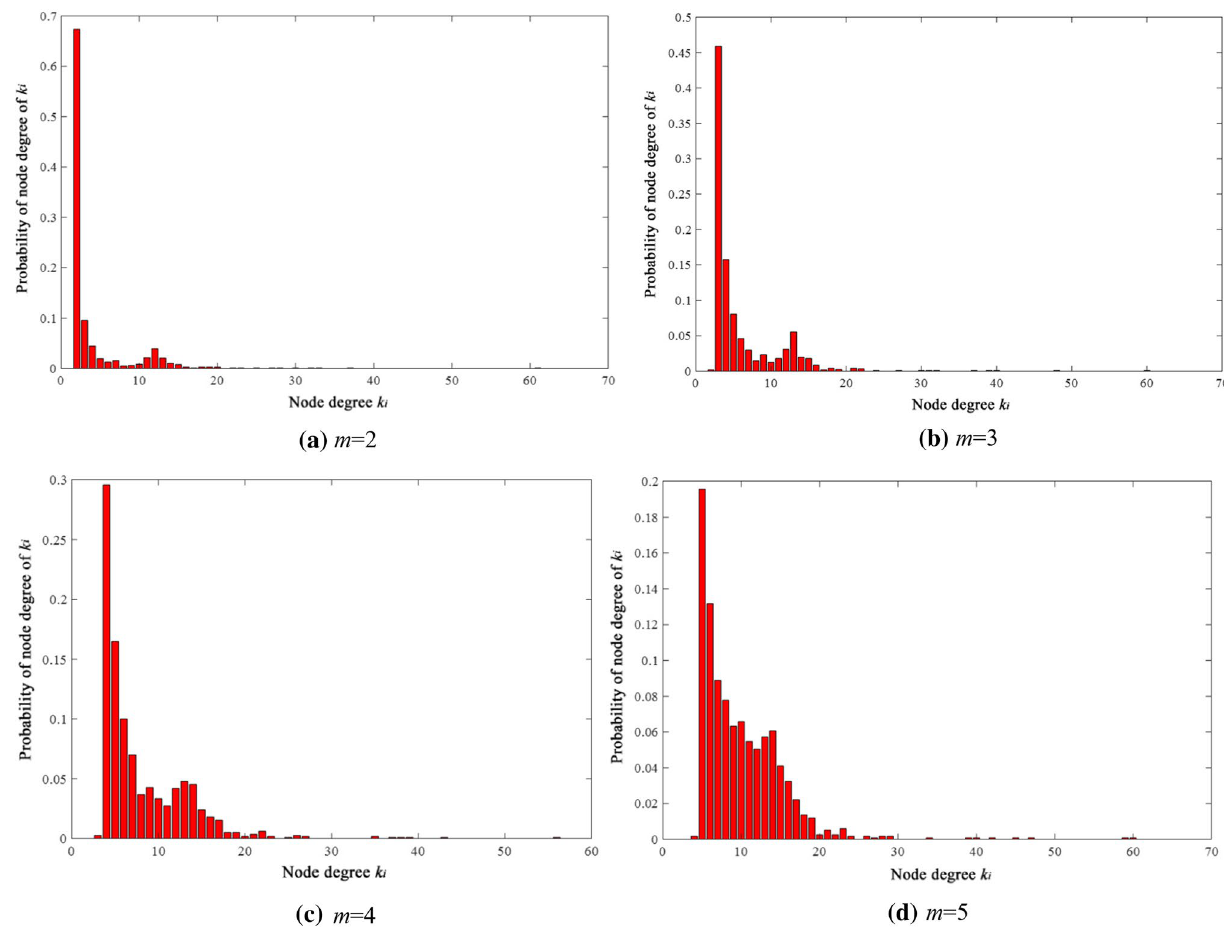
Fig. 6 Probability distribution of node